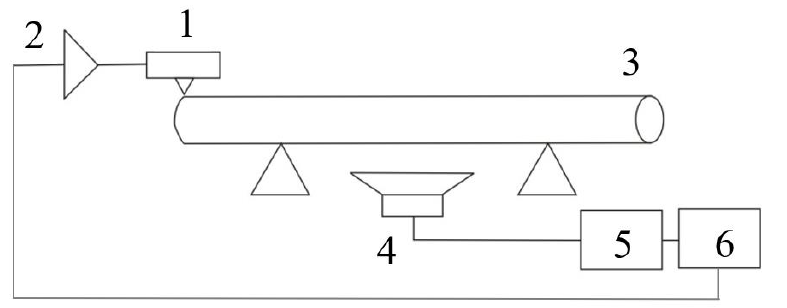
Figure 1. SRM apparatus (1—sensor, 2—preamplifier, 3—sample, 4—exciter, 5—oscillator, 6—per- sonal computer).